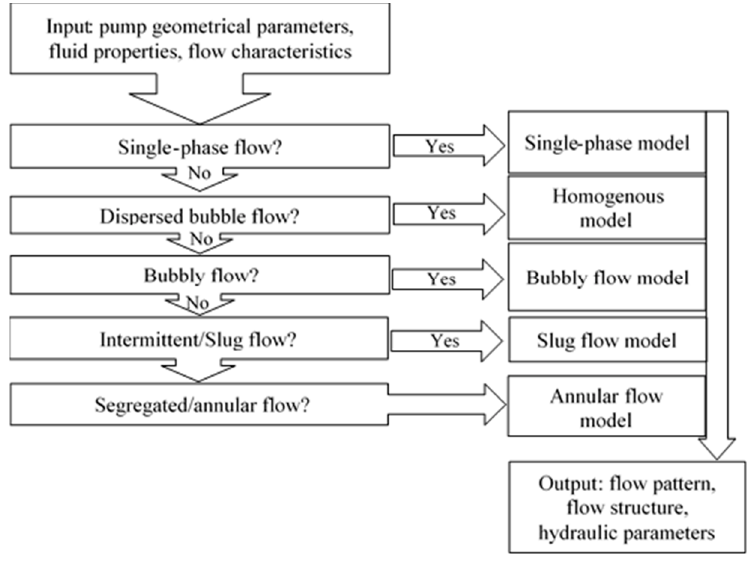
Figure 19. Flow chart for gas-liquid flow calculation inside a rotating ESP impeller .